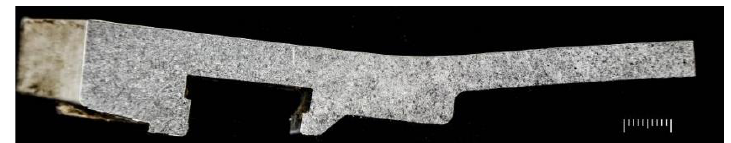
Figure 15. Morphology of the normal section near the outer circle.